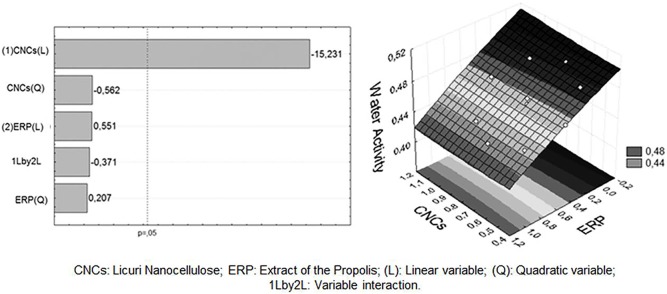
Pareto graph (A) and response surface (B) generated between CNCs, Water Activity and ERP.